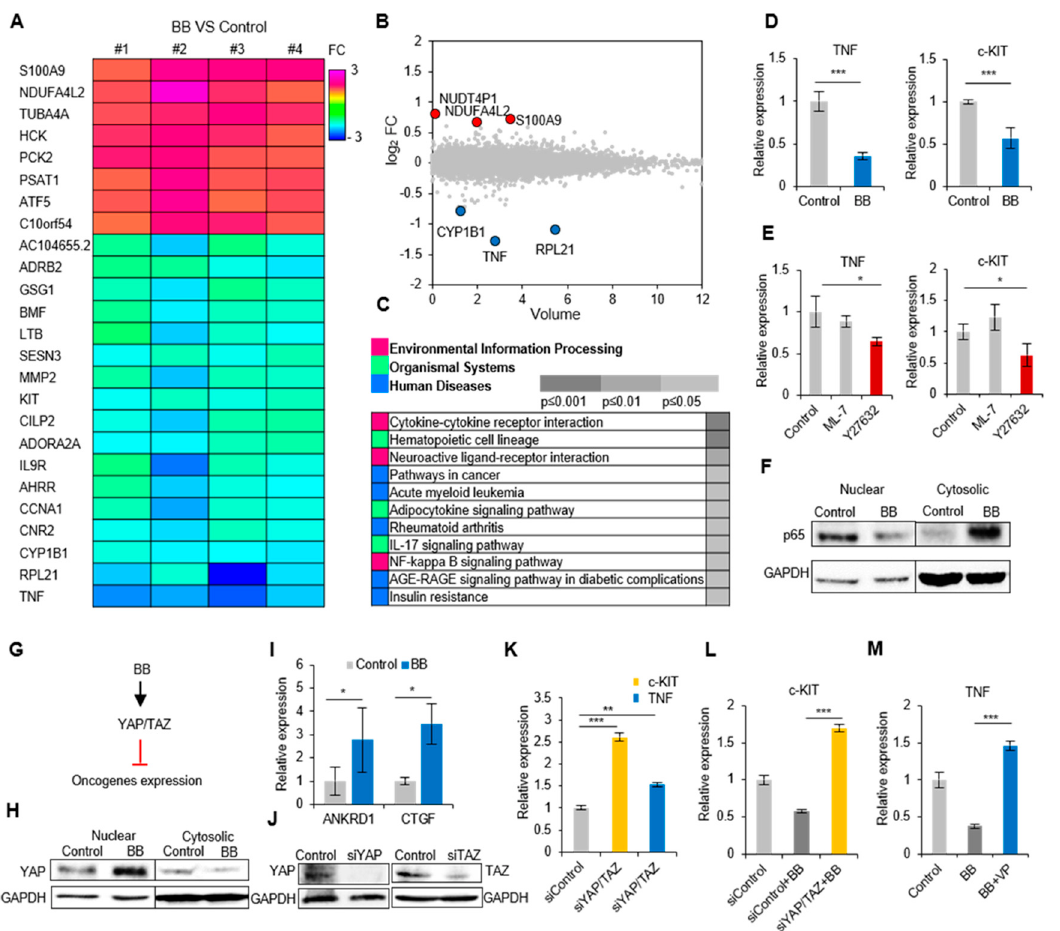
Figure 3. Perturbation of actomyosin contractility induces transcriptional changes in AML cells. ( A ) Heat map of significantly up and downregulated genes (fold change ≥ 1.5) by 50 µM blebbistatin in HL-60 cells ( n = 4). ( B ) The top six genes are shown in a volume plot. Red dots represent upregulated genes, and blue dots represent downregulated genes. ( C ) KEGG pathway analysis of blebbistatin modulated enriched pathway in HL-60 cells. ( D ) Blebbistatin-induced oncogenes changes were verified by qRT-PCR ( n = 6). Data are represented as mean ± SEM. ( E ) Myosin activity induced oncogenes changes in HL-60 cells ( n = 3). ML-7: MLCK inhibitor, Y27632: ROCK inhibitor. Data are represented as mean ± SEM. ( F ) The involvement of NF- κ B signaling was confirmed by immunoblotting. ( G ) Experimental design of signaling nodes in blebbistatin (BB) induced oncogenes changes. ( H ) Immunoblotting of YAP activation upon blebbistatin treatment. ( I ) The expression of YAP regulated genes ( ANKRD1 , CTGF ) were verified using qRT-PCR ( n = 3). Data are represented as mean ± SEM. ( J ) The silencing efficiency of YAP/TAZ siRNA. ( K ) mRNA expression of c-KIT and TNF in Yes-associated protein (YAP)/ transcription regulator protein 1 (TAZ) double knock down HL-60 cells ( n = 3). Data are represented as mean ± SEM. ( L ) The siYAP/TAZ affects blebbistatin induced c-KIT downregulation. Data are represented as mean ± SEM. (M) The verteporfin (YAP–TEAD binding inhibitor) affects blebbistatin induced TNF downregulation ( n = 3). Data are represented as mean ± SEM. * p < 0.05, ** p < 0.01, *** p < 0.001.